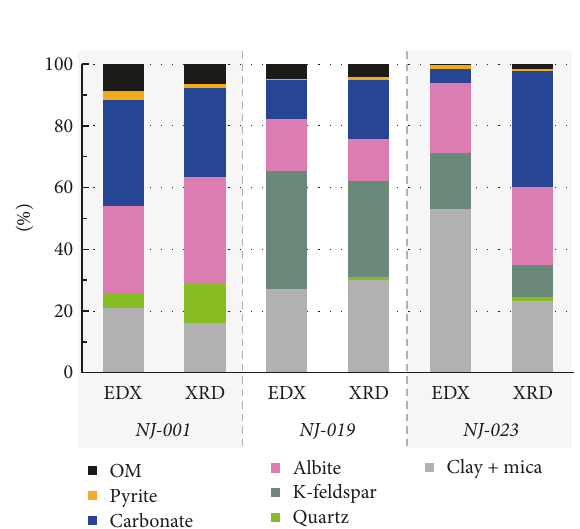
Figure 7: Comparison of EDX and XRD (plus TOC) data, where XRD can be seen as the intrinsic mineralogical